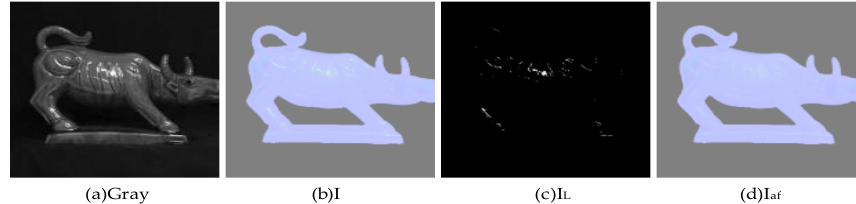
Figure 5. Schematic diagram of reflective correction.